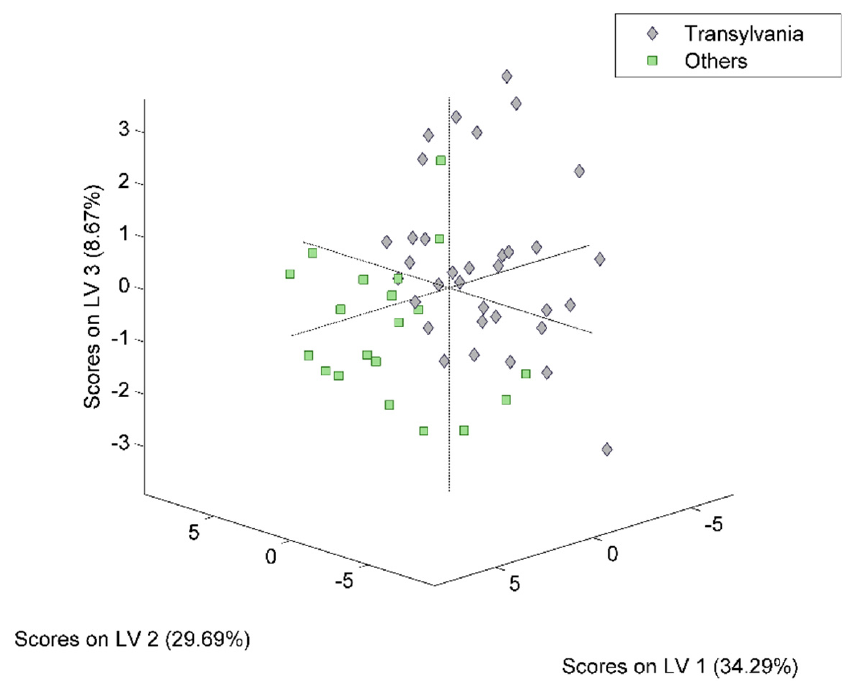
Figure 12. PLS-DA score plot corresponding to the geographical differentiation of honey.